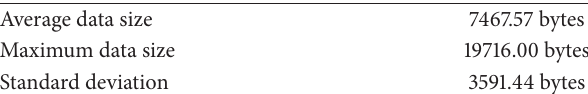
Table 2: Stats of ground data size by